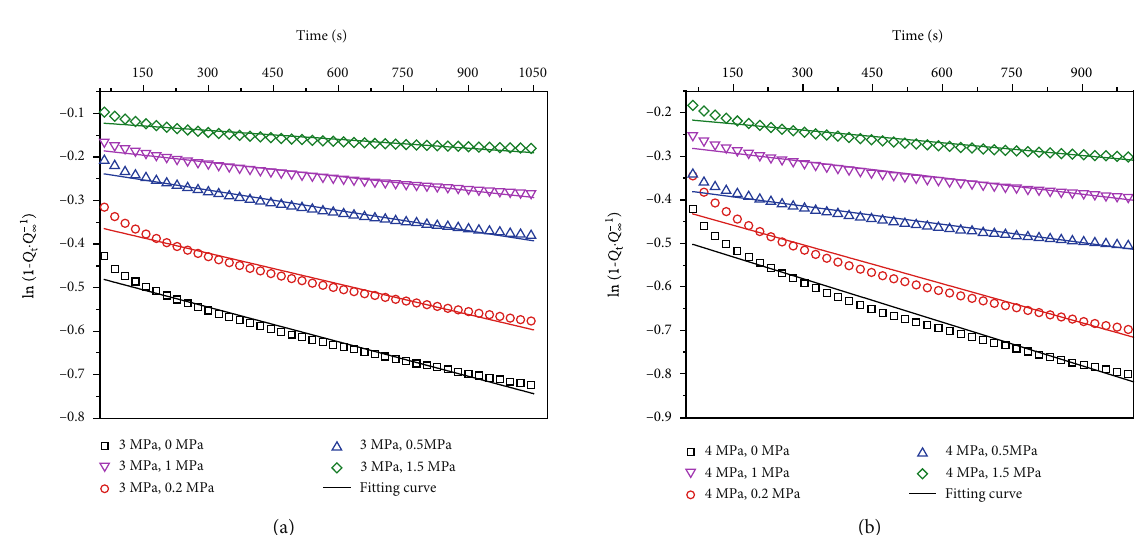
/ Q Þ and t : (a) Sihe sample and (b) Canghai t ∞